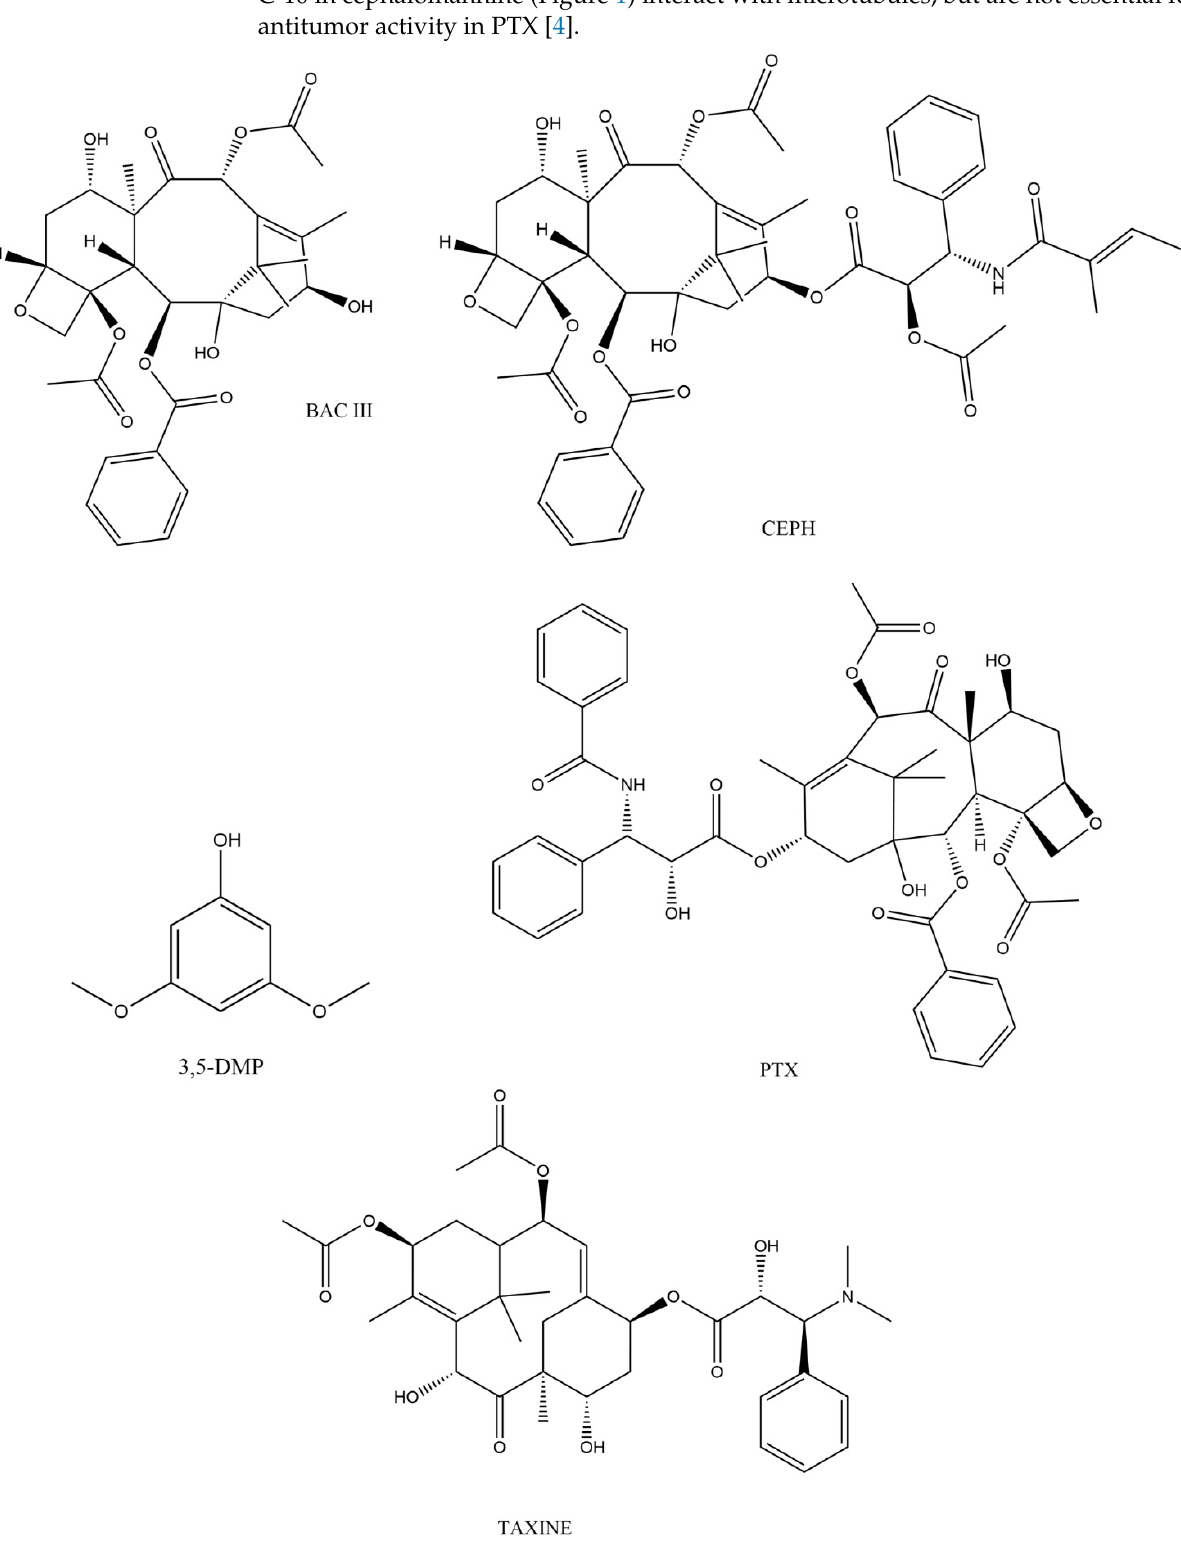
Figure 1. Structures of selected taxanes. Paclitaxel is a white to off-white crystalline powder. It is insoluble in water (5.56 × 10 − 3 g/L), with a melting point near 216 ◦ C, and it is highly lipophilic. In